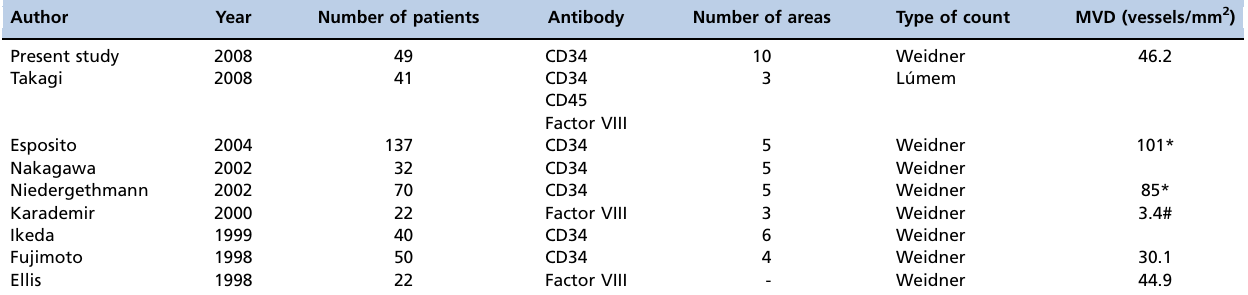
Table 4 - Different methods used to count